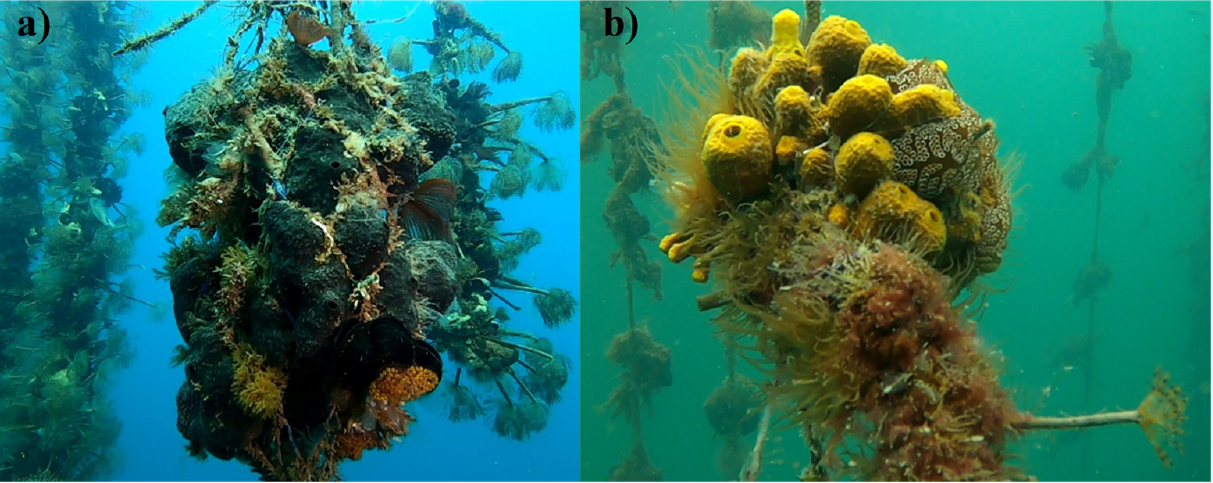
Figure 4. Algae, ascidians, polychaetes, and sea anemones growing on Sarcotragus spinosulus ( a ) and Aplysina aerophoba ( b ) reared in the Remedia Life IMTA system.